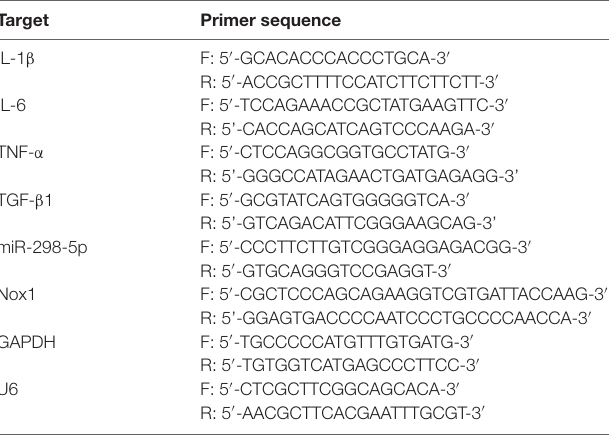
TABLE 1 | Primer sequence of